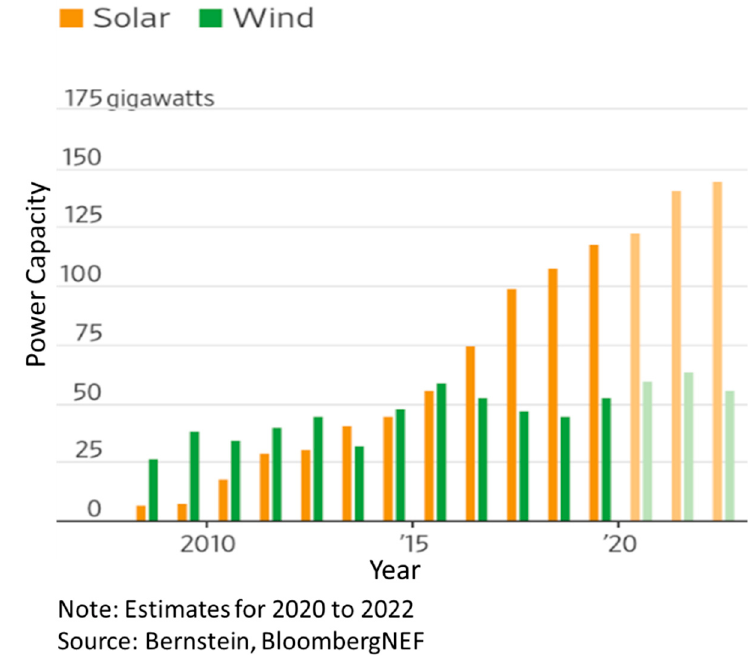
Figure 1. Increase in power generation capacity for solar and wind energies [5].